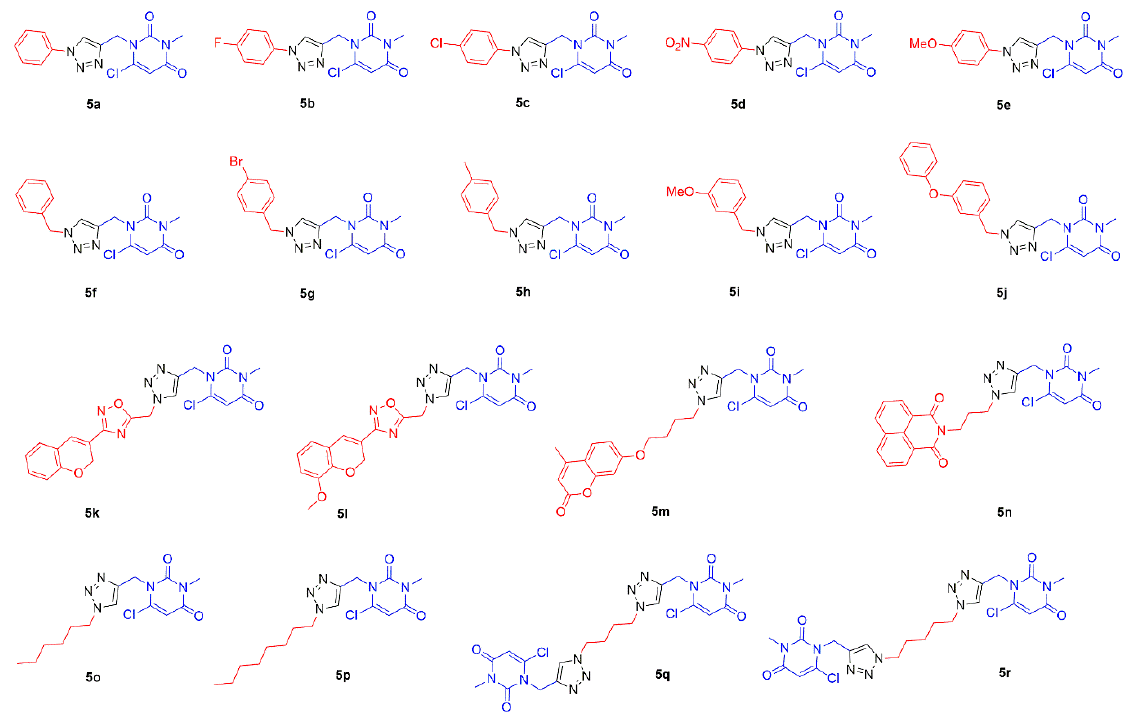
Figure 2. Picture showing all the substituted 1,2,3-triazole-uracil ensembles that were docked into the active site of the VEGFR-2 receptor protein. Table 1. Moldock and rerank scores for compounds 5a – r